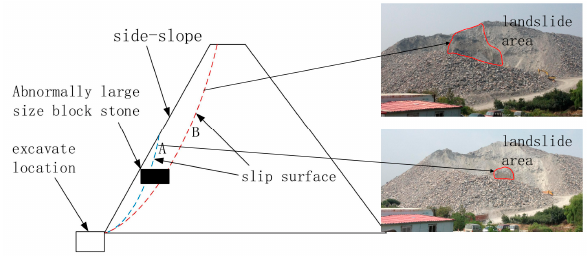
Figure 2. The range indicated by the red line in the figure is the area occupied by the piled rockfill, and the range indicated by the yellow line is the azimuth scanning range of the radar.